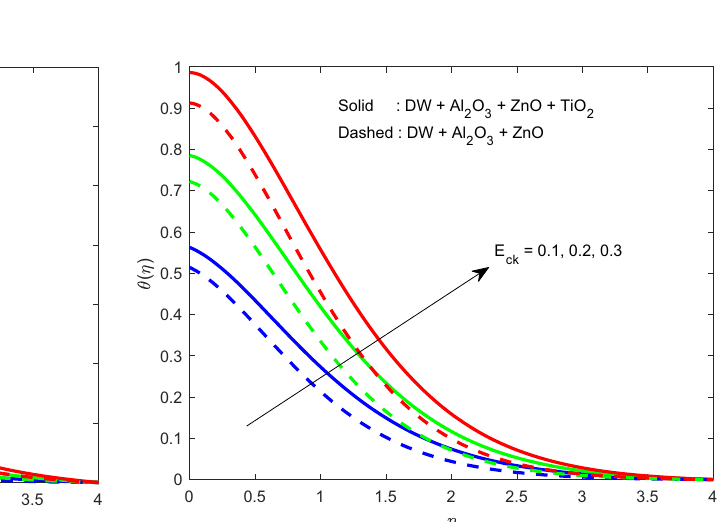
Figure 6: Increasing e ff ects of R a on θ ( η ) .